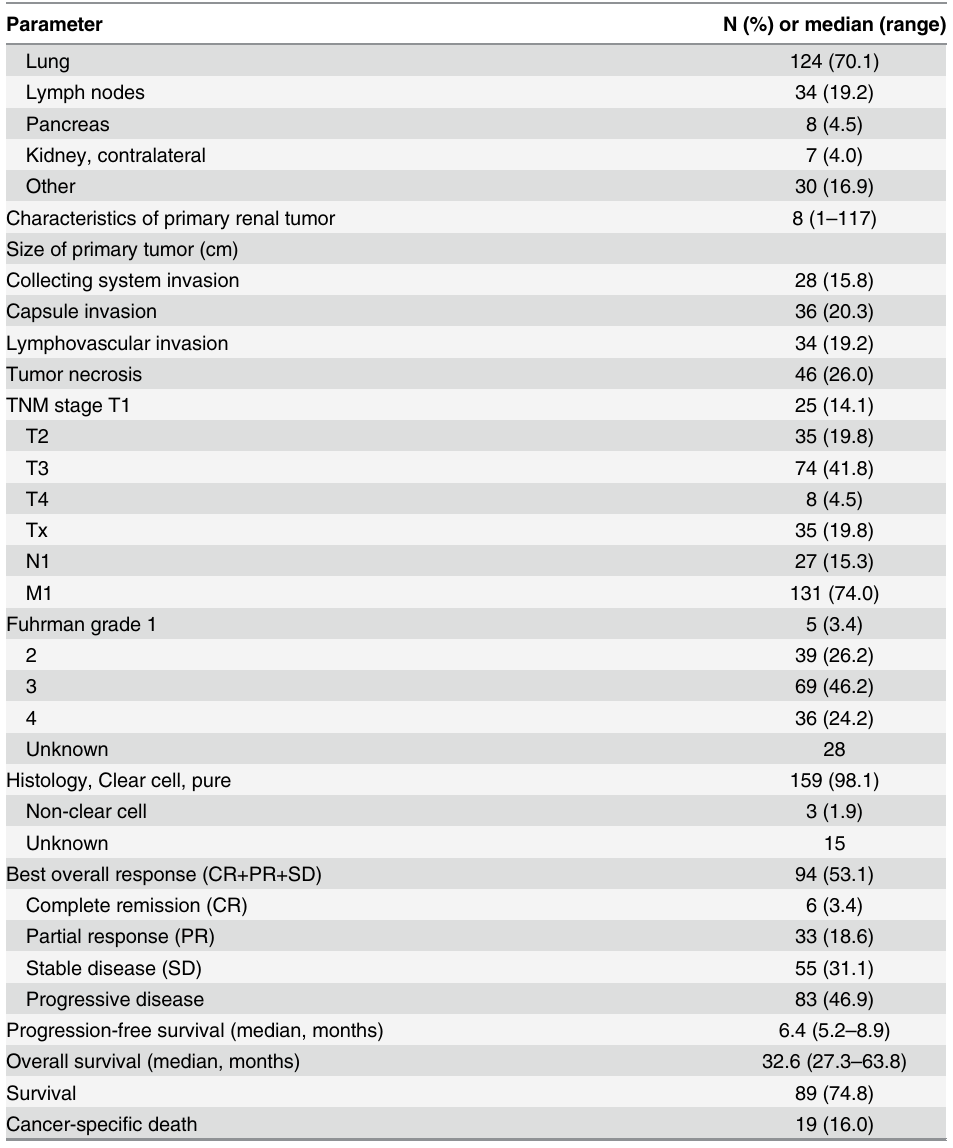
MSKCC, Memorial Sloan-Kettering Cancer Center; TNM, tumor-node-metastasis. patients, the DCRs were 46.5% (2.3+16.3+27.9%) and 38.9% (0+16.7+22.2%), respectively In terms of the safety profile, 1595 AEs occurred among 112 (63.3%) patients during the median 20-week treatment duration; of these, 118 (7.4%) AEs (cid:1) grade 3 in 64 (36.2%) patients, including one myocardial infarction, negatively affected the treatment tolerability (Table 2). Among these 64 patients, 40 (62.5%) received first-line sorafenib, with a (cid:1) grade 3 AE rate of 6.8% observed (71/1048 AEs). The AEs (cid:1) grade 3 included hand-foot syndrome (10.2%), ane- mia (5.6%), hypertension (4.0%), and serum lipase elevation (4.5%), with the most common AEs to cause discontinuation, reduction, or interruption of sorafenib being hand-foot skin